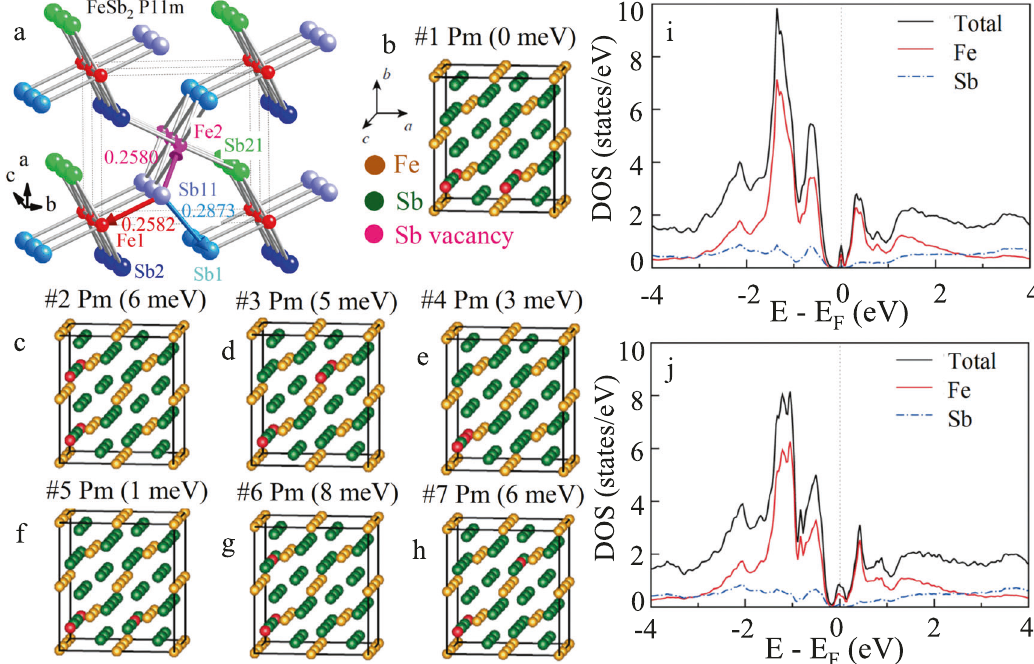
Fig. 4 Pm space group and corresponding band structure calculation. a Crystal structure of FeSb 2 in the Pm space group. Note that Sb- de fi cient Sb11 atomic site are apical for Fe1, whereas they are within octahedral plane for Fe2. Bond distances to Fe1, Fe2, and Sb1 are shown in nm. Sb11 atomic sites are separated by the unit cell distance along Pmc axis (3.194 Å ), whereas they are closer to Sb1 sites along the b -axis (2.878 Å ). b – h Different arrangements of two Sb vacancies in the supercell and their energetics. The arrangement consistent with the Pm space group has the lowest energy, in agreement with the experiment. Projected density of states for i one and j two Sb vacancies. Notice that the antimony vacancy gives rise to an iron impurity